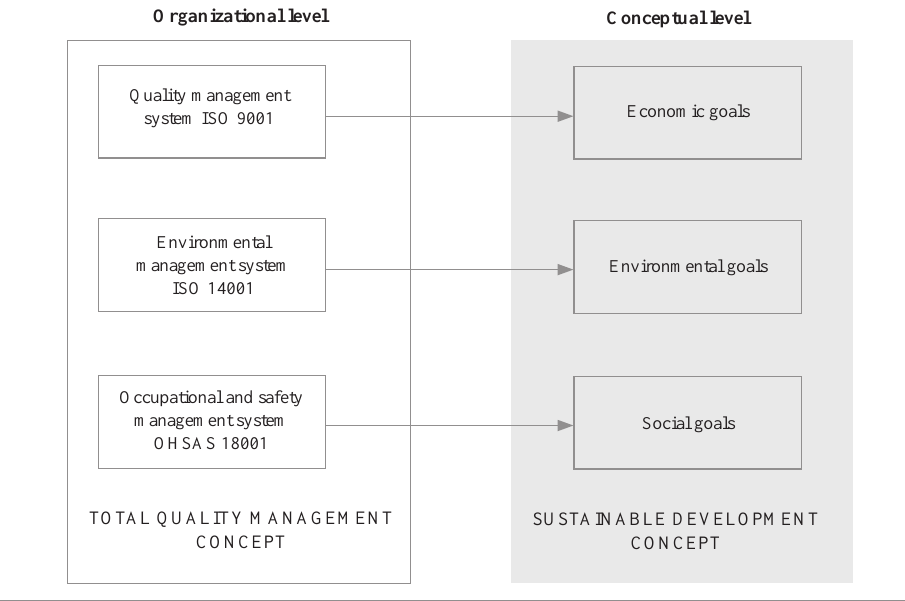
Fig. 1. Relationship between sustainable development concept and practical implementation at organizational level